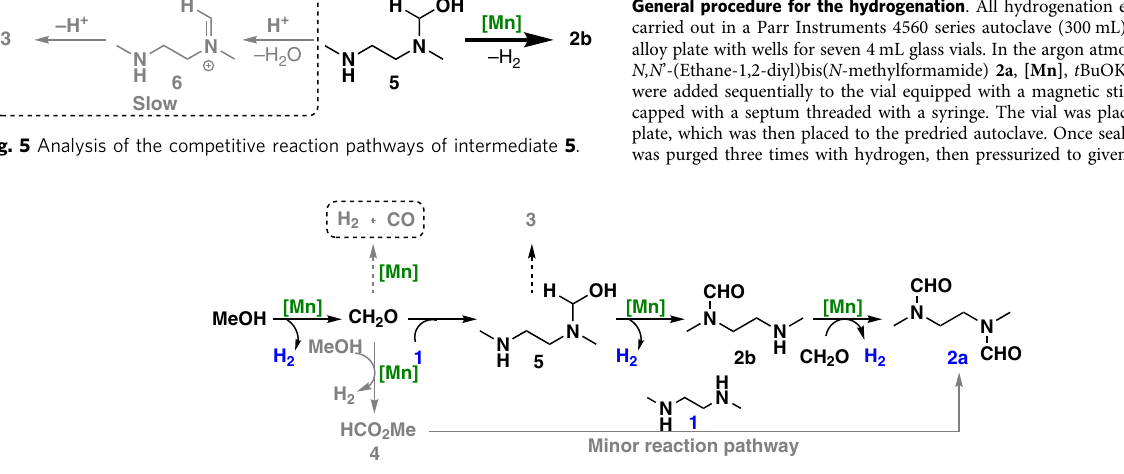
Fig. 6 Plausible reaction pathways for dehydrogenative condensation of methanol and 1